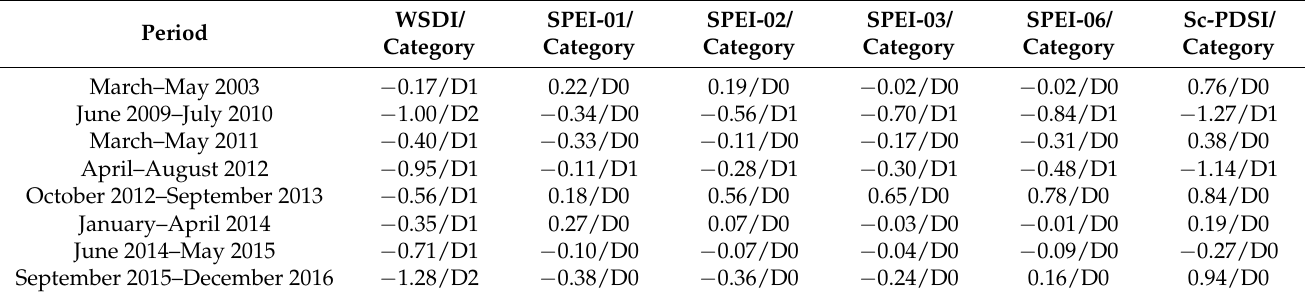
Table 4. Drought severity categories are based on several drought indicators.